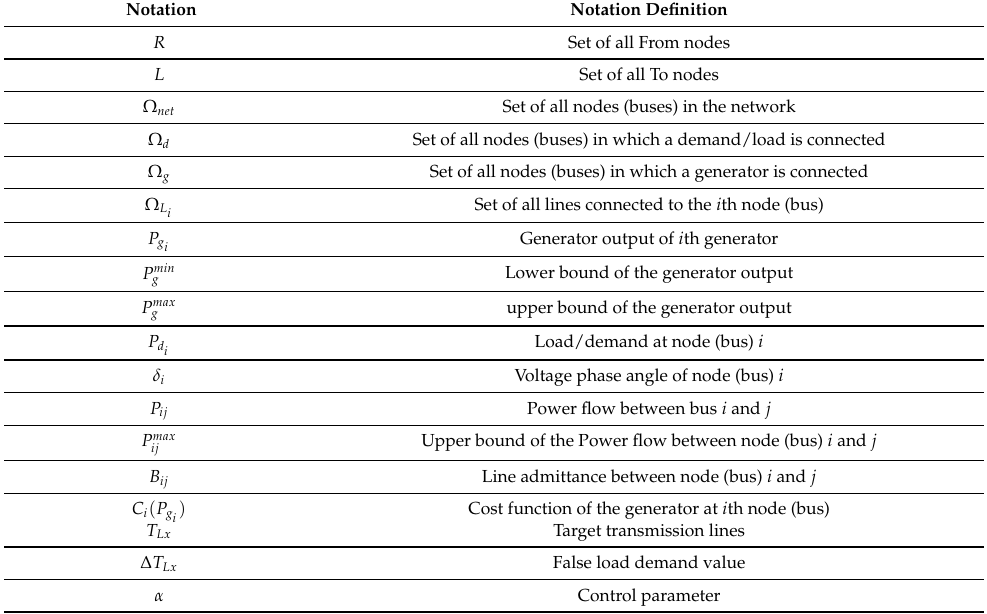
Table 2. Modeling